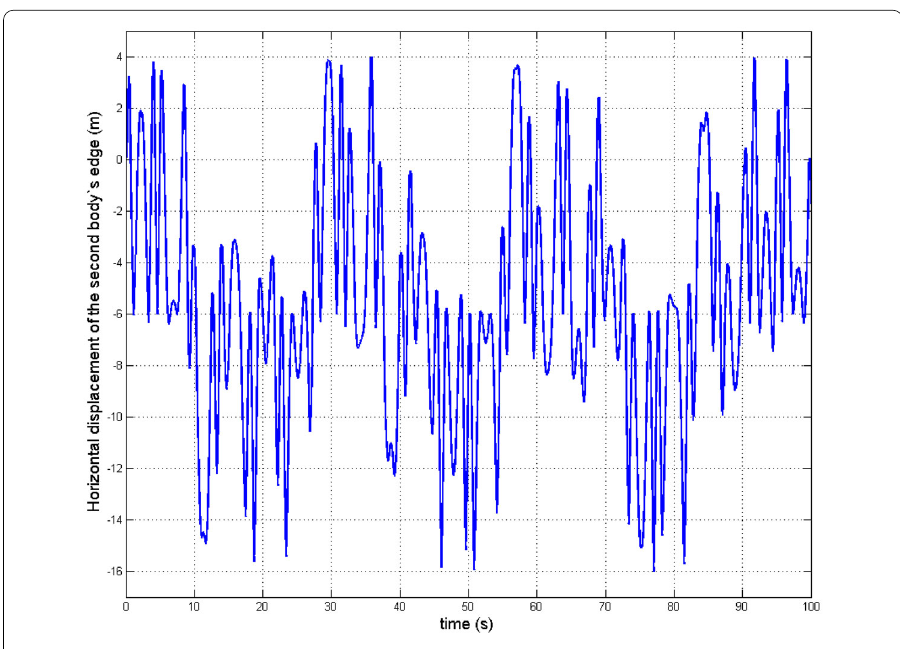
Fig. 13 Horizontal displacement versus time